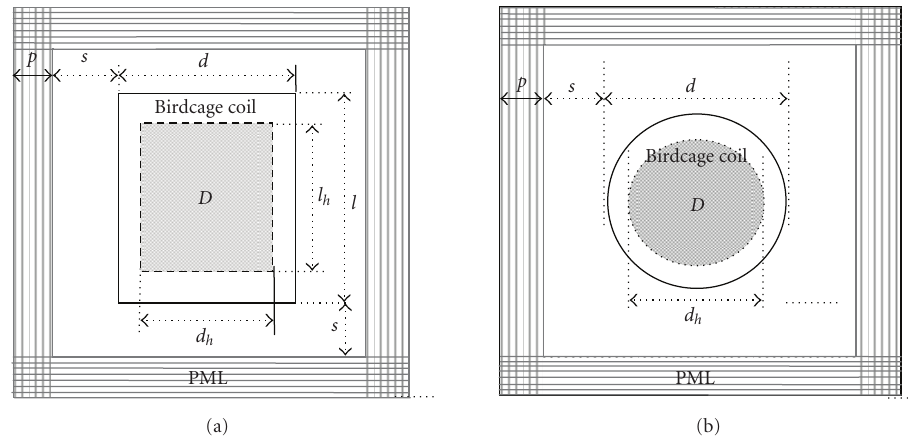
Figure 2: The schematic view of the computational domain. (a) Longitudinal plane ( xoz -plane in Figure 1(b)). (b) Transverse plane ( xoy - plane in Figure 1(b)). “ D ” homogenous region of B 1 -field (shaded); “ p ”: the thickness of the PML; “ s ”: the distance from PML to the closest point on the coil geometry; “ d ”: the diameter of the coil; “ l ”: the length of the coil; “ d h ”: the diameter of region D ; “ l h ”: the length of region D . The dark solid rectangle and circle denote the outline of the coil in the longitudinal plane and transverse plane,